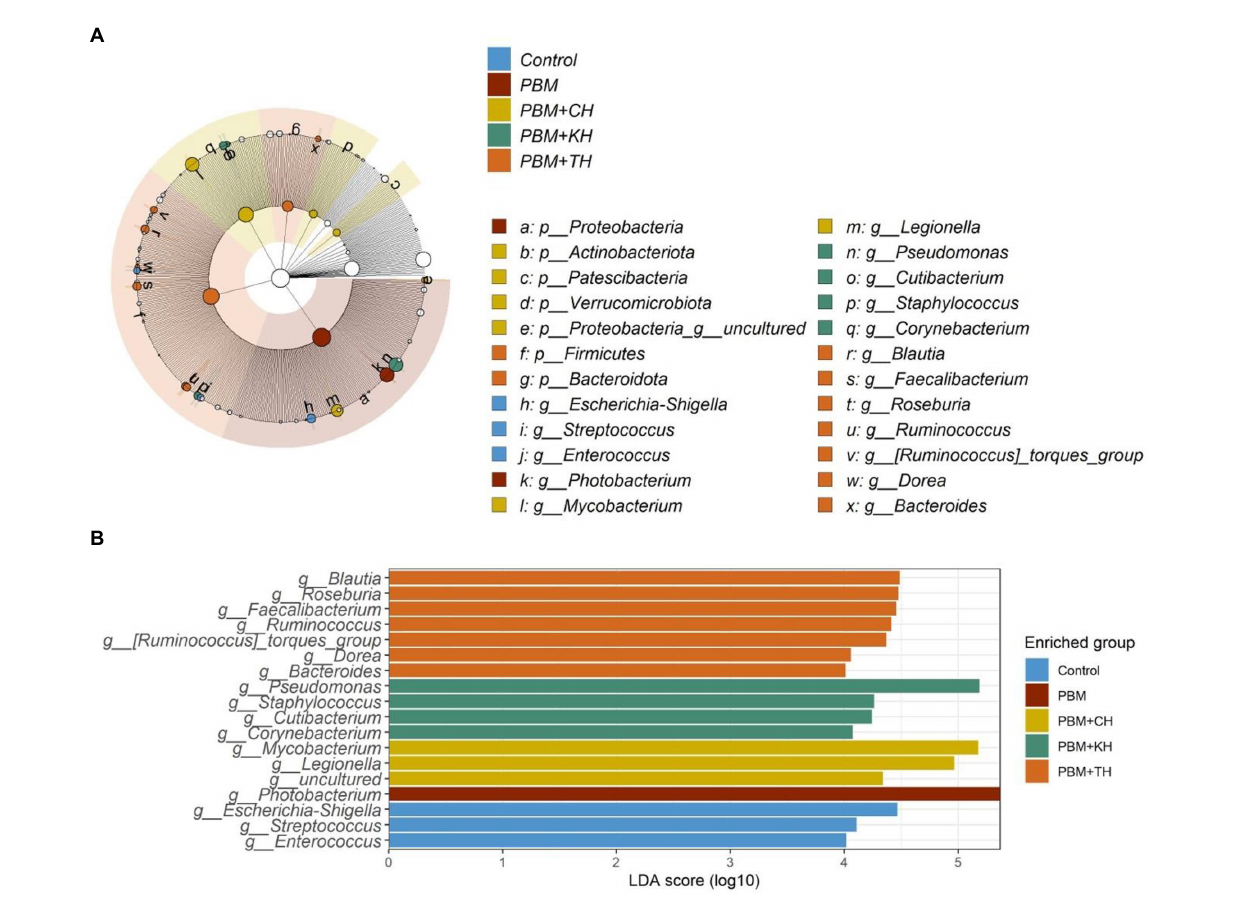
FIGURE 5 Differential abundance of bacterial communities in barramundi fed FM-based control, PBM alone or supplemented with various FPHs supplemented diet over a period of 42 days. LDA value of ≥ 4.0 and p value > 0.05 were considered for differential abundance